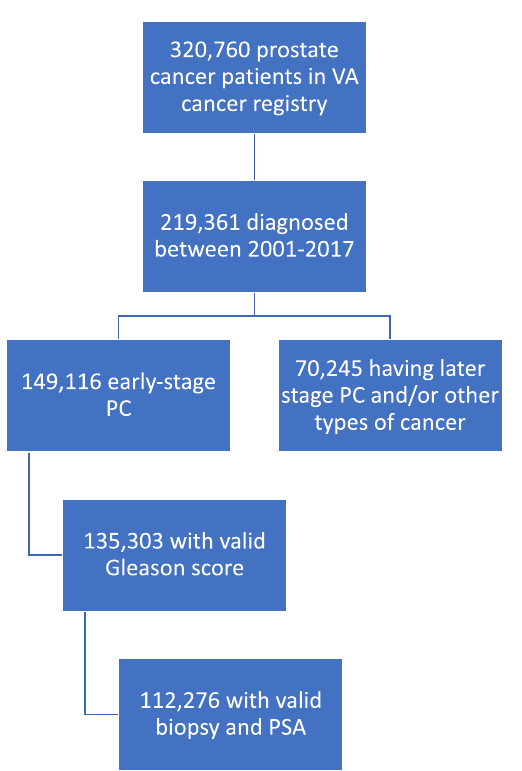
Figure 1. Deep learning model overview. The neural network is responsible for learning the feature representation � θ ( X ) , given the input X . The parameters of all k distributions, β k , and their mixing weights, w k , are learned jointly during the training.